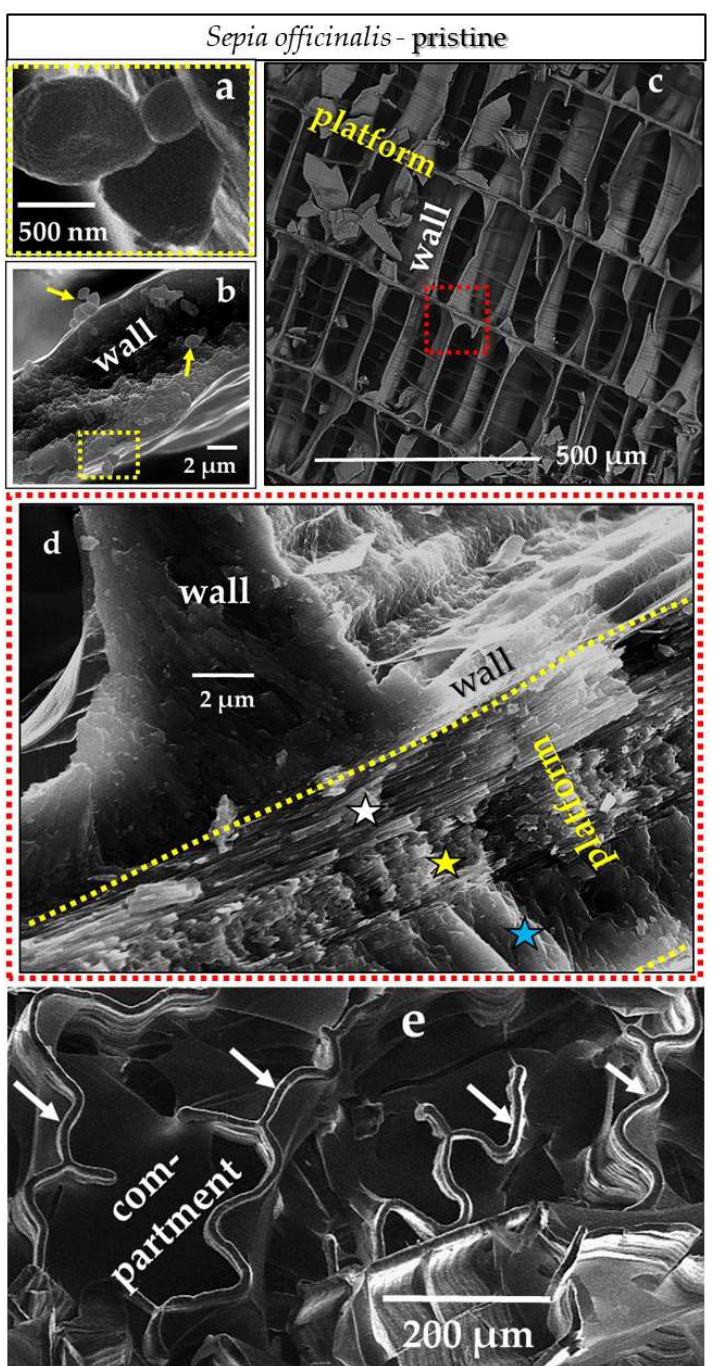
Figure A11. FE-SEM images visualizing the macro-, micro- and nanostructure of pristine Sepia officinalis cuttlebone. ( a ) The cuttlebone is a lightweight structure comprising horizontal platforms and vertical walls, this arrangement of structural elements renders stability but also induces the formation of compartments; ( b ) the vertical walls (see view from above) are stabilized from implosion by vertical stop ridges consisting of thick biopolymer membranes (see ( a )). Both, the walls and ridges consist of nanoparticulate aragonite ( d , e ). The platforms comprise arrays of aragonite rods ( f ), with the stacks of rods showing a well-defined twisted arrangement (white and yellow stars in ( c )).